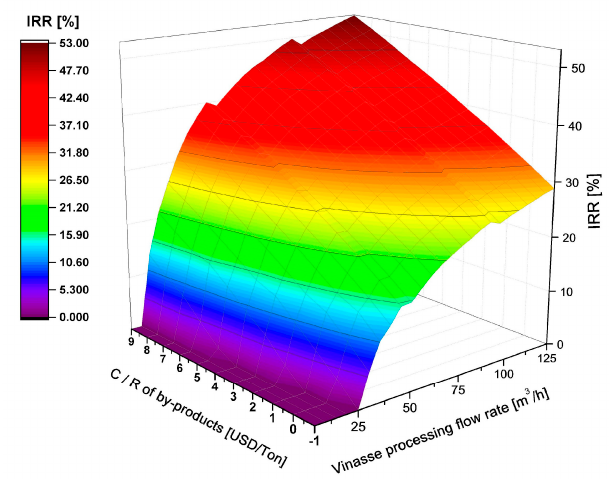
Figure 8. Internal rate of return as a function of the vinasse processing flow rate and cost/return of the digestate for a vinasse-fed AD plant.